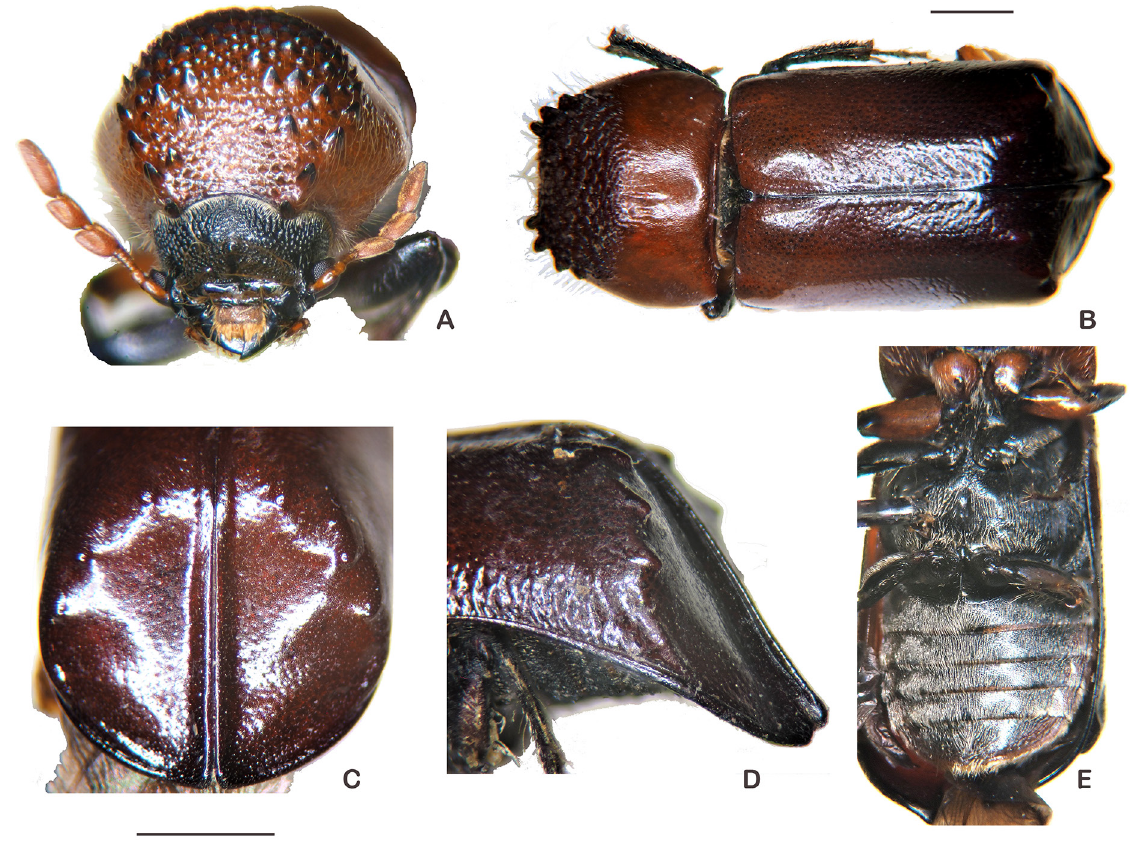
Fig. 4. Calophagus pekinensis Lesne, 1902, ♀ (SNSD). A . Frontal view. B . Dorsal view. C . Declivity. D . Lateral view of declivity. E . Ventral view. Scale bars = 1 mm (upper scale for B, E; lower scale for A,